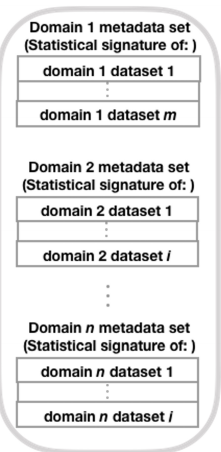
Figure 3. Statistical signature combination (adapted from Brena et al.